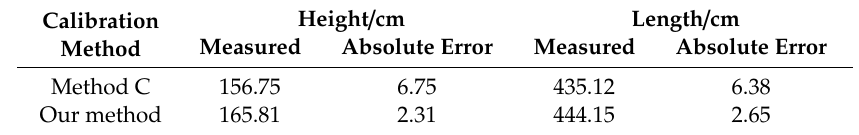
Figure 8. Point cloud fusion results of car model. Red point clouds are the result of our method. Green point clouds are the result of method C. ( a ) and ( b ) are the results of method C and our method, respectively. ( c ) is the front of the porcelain car model. ( d ) is the ground of the car model.